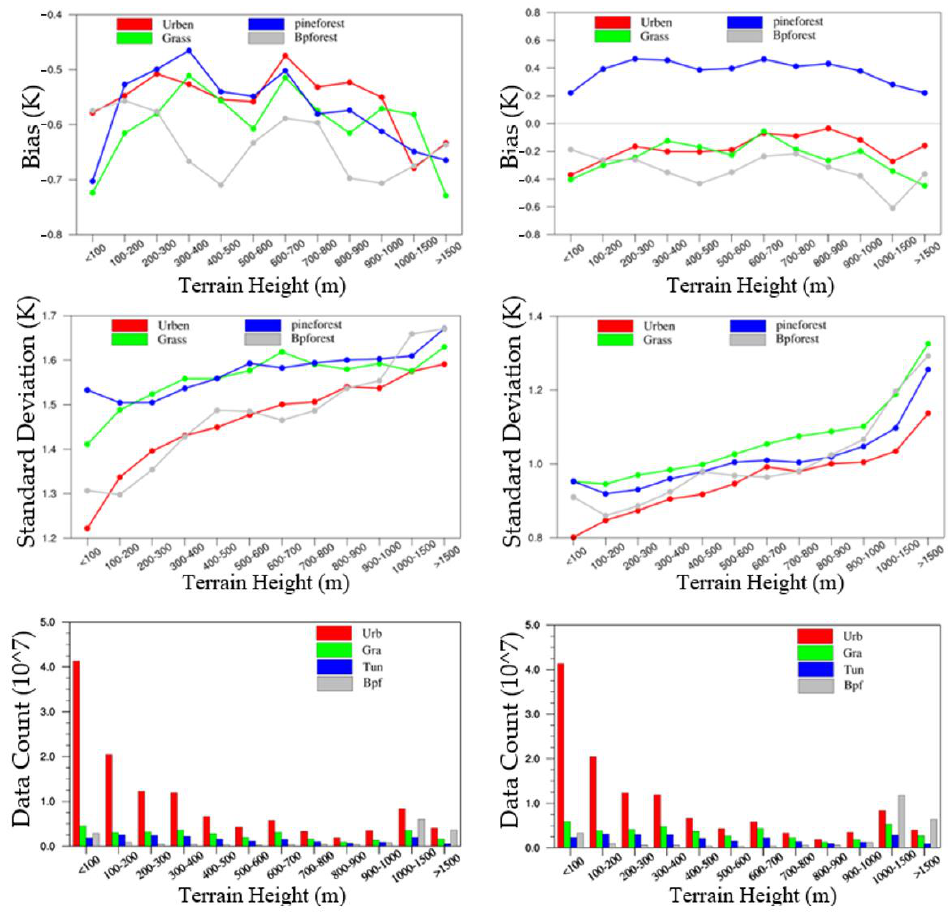
Figure 8. O-B bias (above column curve) and standard deviation (middle column curve) values of four vegetation types: (urban (red), grasslands (green), pine forests (blue) and broadleaf forests (grey)) on channel 14 ( left ) and channel 16 ( right ) of the AHI, and the changes in the numbers of these four vegetation types (columns) identified at different heights (below).